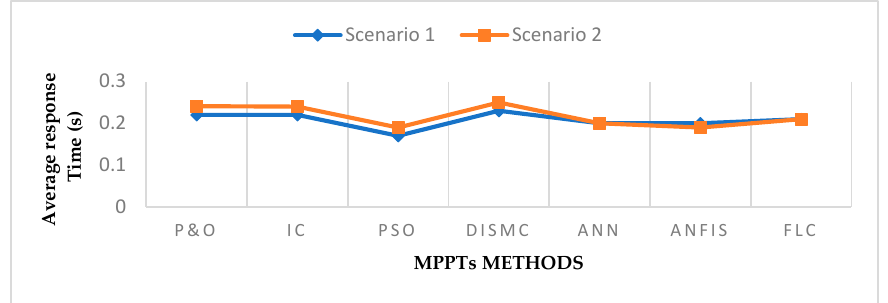
Figure 19. Average response time of MPPT algorithms: Test 2.